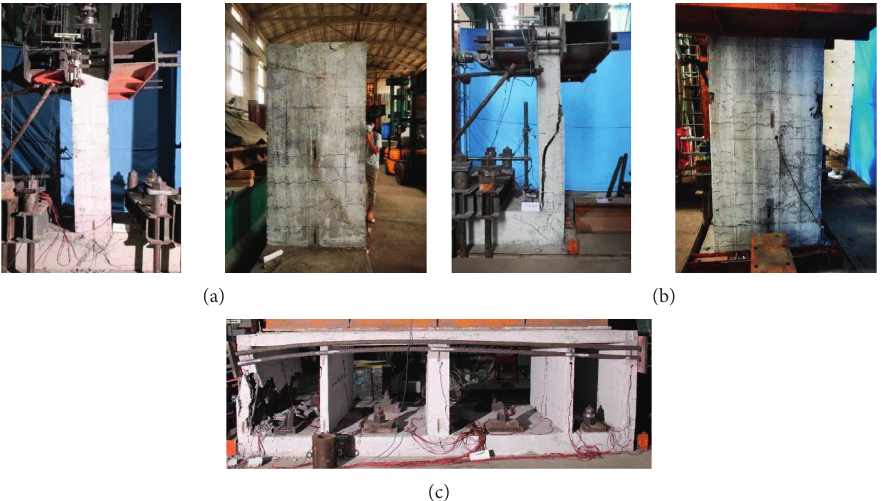
Figure 4: Joint failure mode: (a) middle joint specimen; (b) side joint specimen; (c) overall